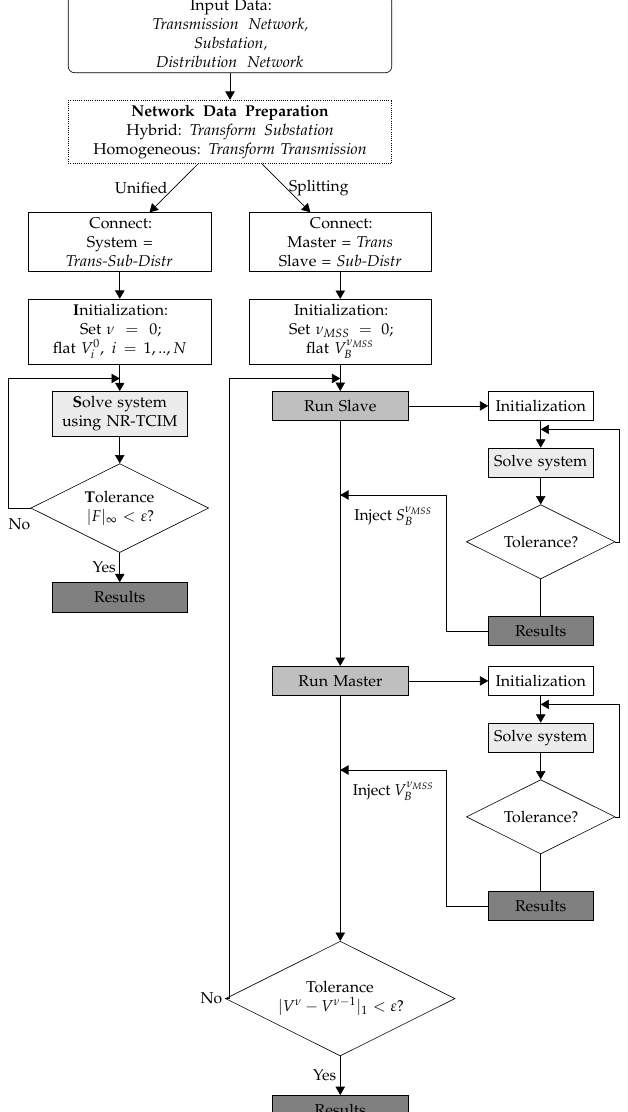
Figure 2. Algorithmic process of the unified and splitting